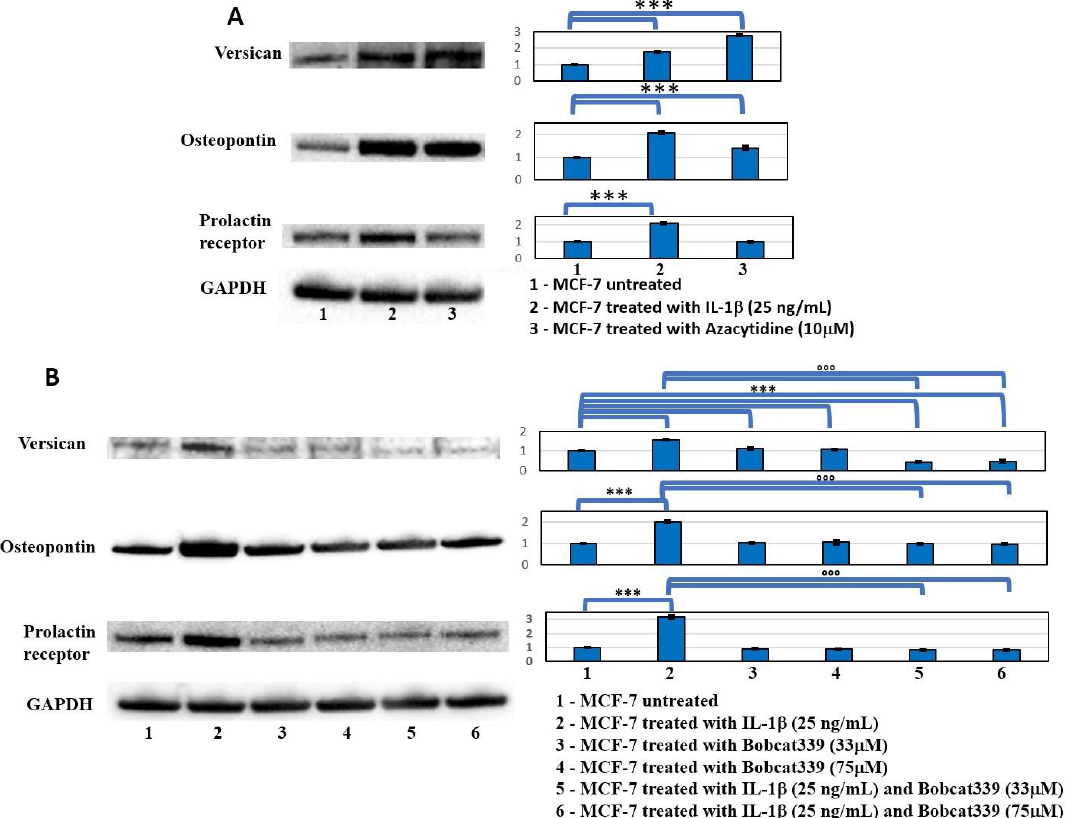
Figure 5. Western blot analysis of principal marker of bone homing. ( A ) Western blot analysis of Versican, Osteopontin, and Prolactin receptor in MCF-7 cells untreated and treated with IL- 1 β and AZA after 48 h. Representative images of WB and densitometric analysis (Mean ± SD) of Versican, Osteopontin, and Prolactin receptor. One-way ANOVA showed significant effect of treatment on densitometric data ( p < 0.0005); significant differences were highlighted among tested treatments ( p < 0.0005), except for Prolactin receptor with AZA ( NS ). ( B ) Western blot analysis of Versican, Osteopontin, and Prolactin receptor in MCF-7 cells untreated and treated with IL-1 β and Bobcat339 (33 µ M and 75 µ M) and relative co-treatments after 48 h. Representative images of WB and densitometric analysis (Mean ± SD, n = 3) of Versican, Osteopontin, and Prolactin receptor. One-way ANOVA showed significant effect of treatment on densitometric data; significant differences among tested treatments versus untreated MCF-7 (*), and among IL-1 β /BC co-treatments versus the IL-1 β one ( ◦ ) are reported in the graphs (*** and ◦◦◦ , p <